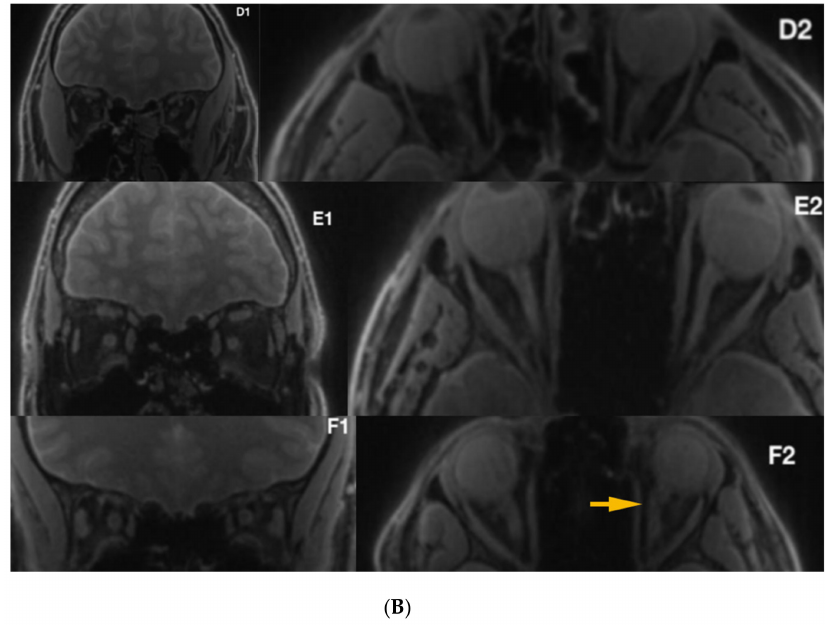
Figure 4. ( A ) Silent-MT images in 3 LHON subjects who received Idebenone therapy. The yellow arrows show irregularity within the optic nerve. ( B ) Silent-MT images in three LHON subjects who received Idebenone therapy. Optic nerve atrophy is not visible in Patient F, (disease duration more than one year), however the yellow arrow shows more tortuous anatomy of the optic nerve, which is consistent with the side of the disease. MT, Magnetization Transfer.